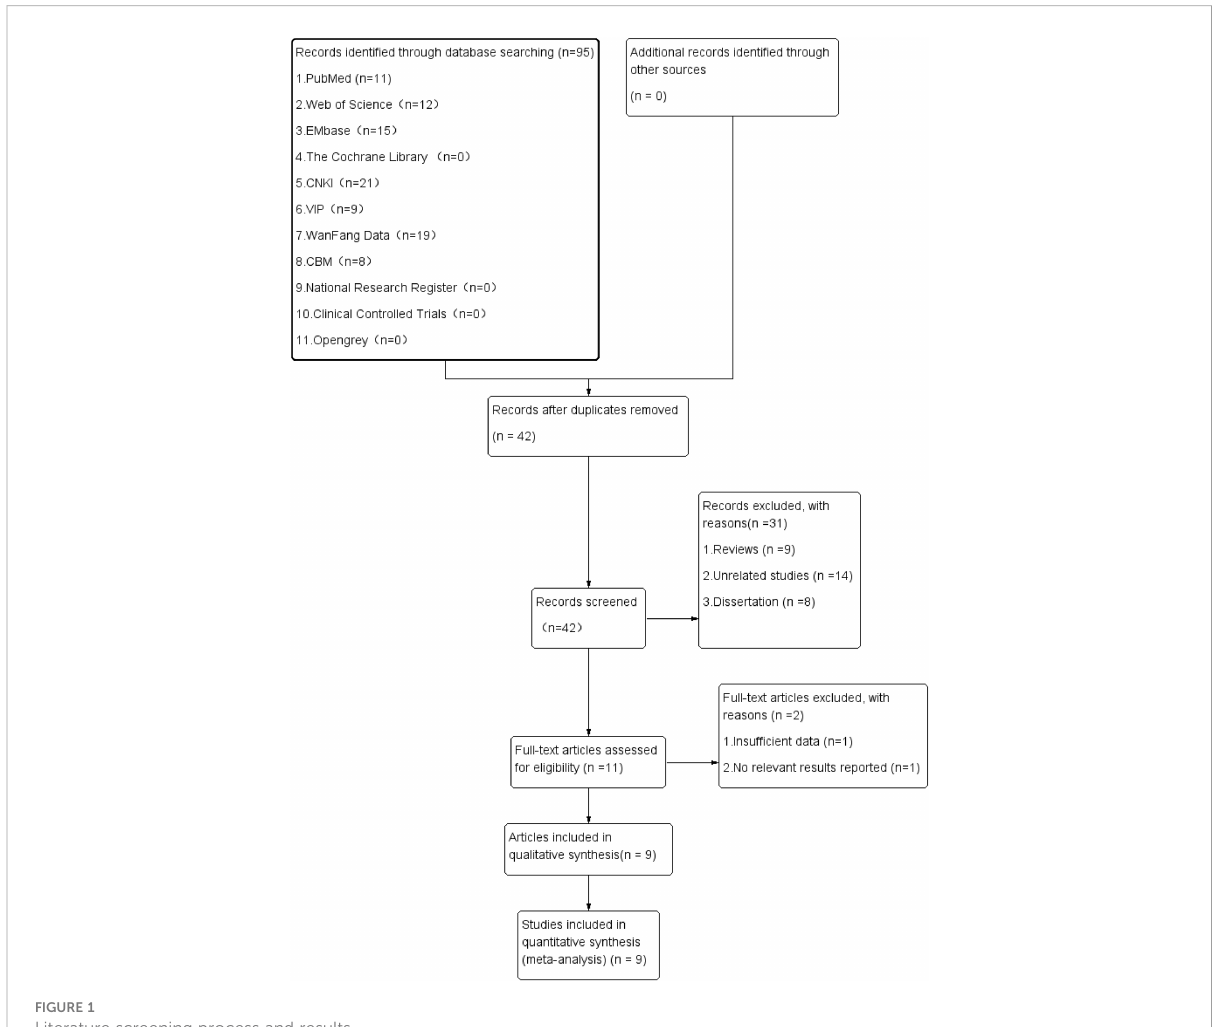
FIGURE 1 Literature screening process and results.